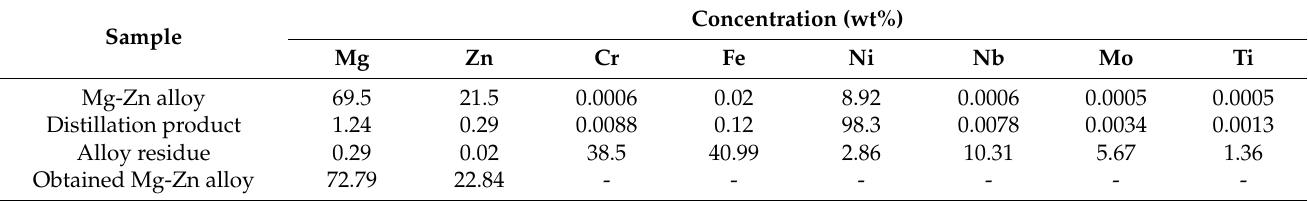
Table 2. Chemical analysis of the samples before and after the distillation